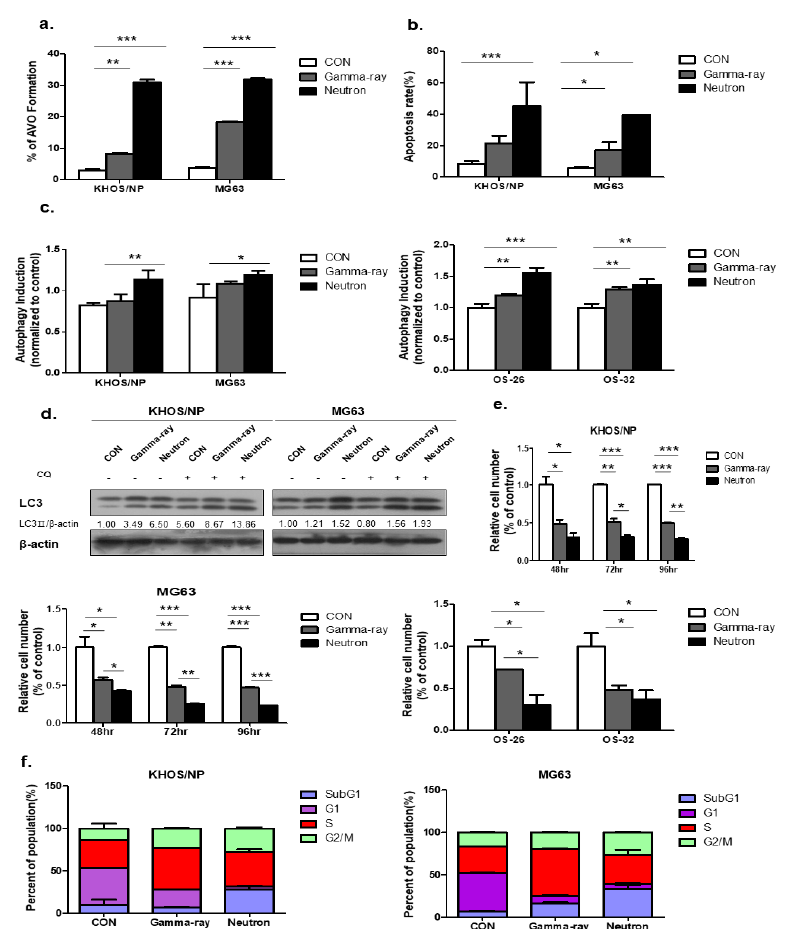
Figure 1. Autophagy induced by neutron exposure. ( a ) Cells were treated with gamma-rays and neutrons for 48 h and then stained with acridine orange (AO). Green and red fluorescence in AO-stained cells were detected by flow cytometry; * p < 0.05, ** p < 0.01, *** p < 0.001. ( b ) Apoptosis rate assessed by FACS analysis after 72 h irradiation (IR) treatment; * p < 0.05, *** p < 0.001. ( c ) Neutron treatment resulted in an increased Cyto-ID dye signal in KHOS / NP and MG63 cells and primary cells derived from a tumor sample from a patient with osteosarcoma (OS) at 48 h; * p < 0.05, ** p < 0.01, *** p < 0.001. ( d ) Immunoblot of LC3 in KHOS / NP and MG63 cells exposed to neutron radiation for 48 h. ( e ) KHOS / NP and MG63 cells and primary cells from a tumor sample from a patient with OS were treated with each type of radiation for 48 h, and the proliferation rate was measured by cell counting; * p < 0.05, ** p < 0.01, *** p < 0.001. ( f ) After 48 h, the cell cycle distribution was analyzed quantitatively. Values represent the means of three experiments _